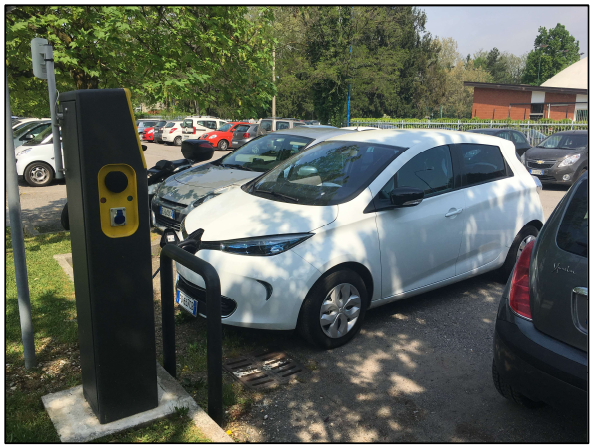
Figure 10. The test EV (Renault Zoe R240) and the private EVSE (provided by Ducati Energia) involved in the experimental characterization. EV: Electric Vehicle, EVSE: EV Supply Equipment.